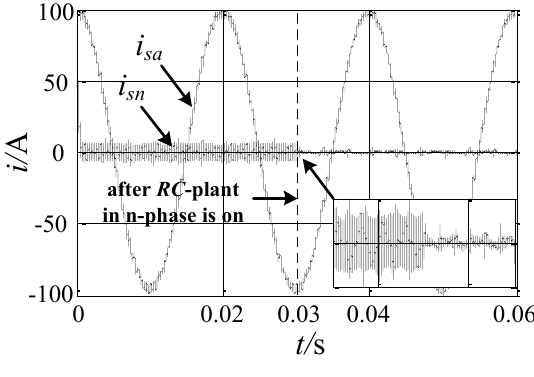
Figure 11. Comparison with and without the LCL branch in phase